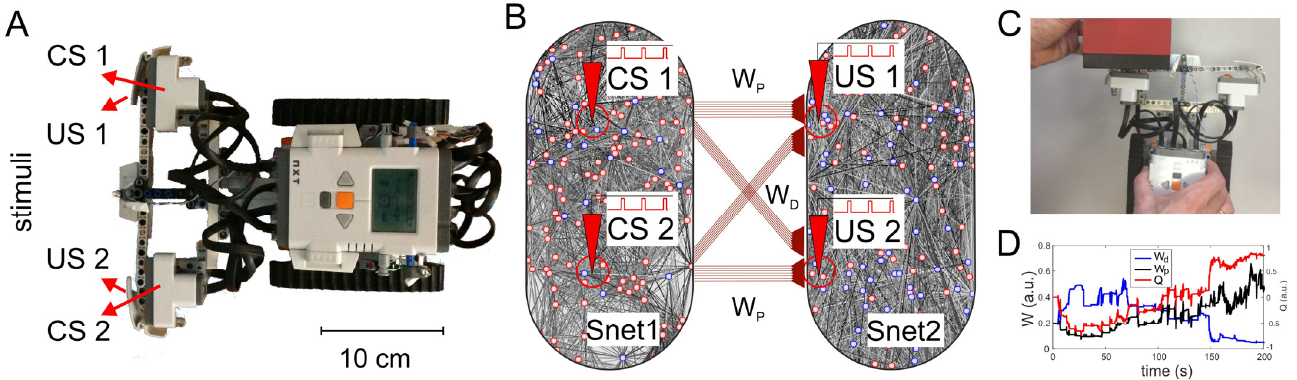
Figure 7. Embedding a modular SNN capable of Pavlovian conditioning in a mobile robot. The robot learns collision avoidance. ( A ) The LEGO robot and mapping of sensory stimuli. ( B ) Modular SNN consisting of two subnets connected by unidirectional couplings ( W P and W D ) and the configuration of stimuli. ( C ) Training the robot. The left touch sensor and left ultrasonic sonar are simultaneously triggered. ( D ) The dynamics of the connections W P and W D , and the learning quality Q during learn- ing.